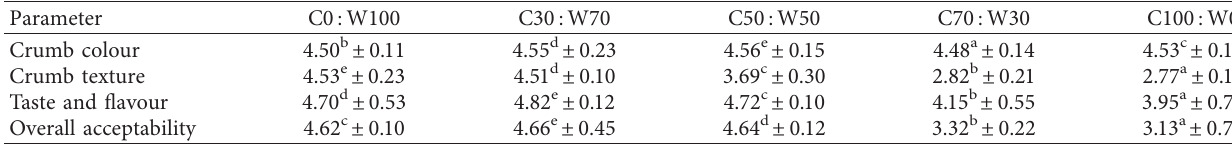
Mean ± standard deviation ( n � 3). Different letters in the same row represent significant differences between samples ( P ≤ 0 . 05). C0:W100: 100% water (control), C30:W70: 70% water and 30% camel milk, C50:W50: 50% water and 50% camel milk, C70:W30: 30% water and 70% camel milk, and C100:W0: 100% camel milk.